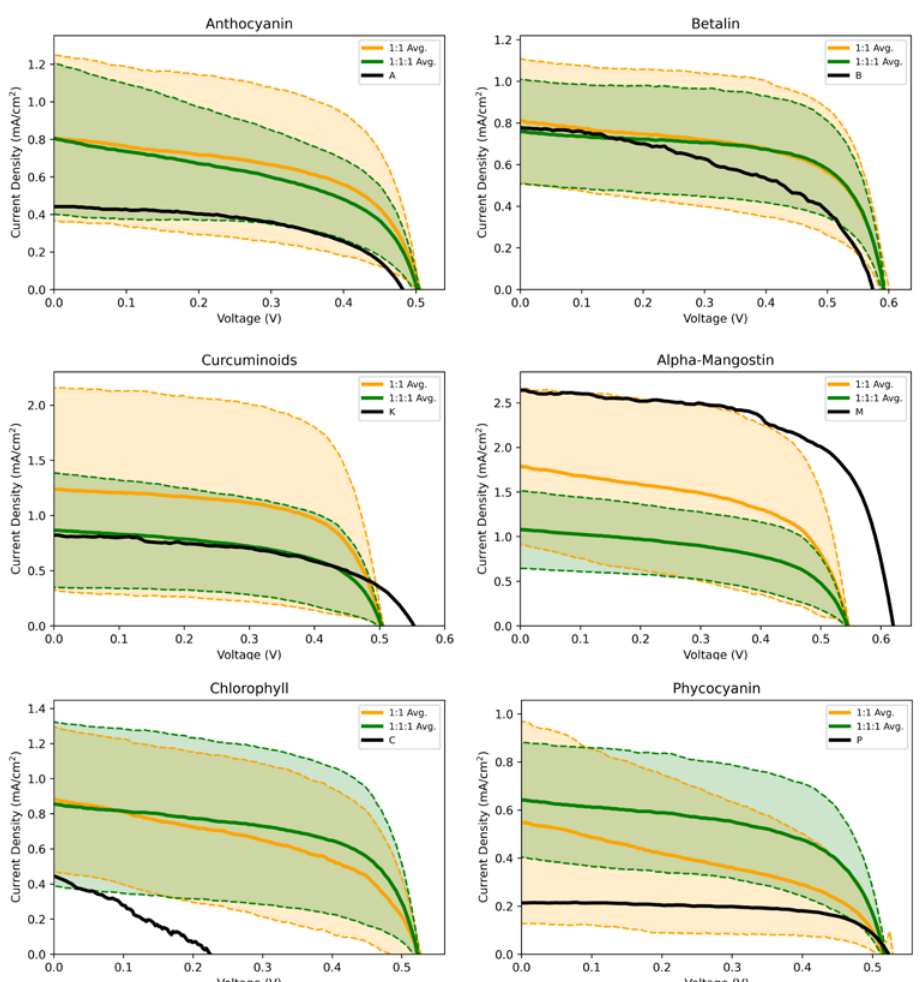
Figure 10. Co-sensitization trends of each parent dye. For example, the Anthocyanin plot shows an orange band averaged from the IV performance of: AB, AK, AM, AC and AP, and a green band averaged from the performance of: ABK, ABM, ABC, ABP, AKM, AKC, AKP, AMC, AMP and ACP.